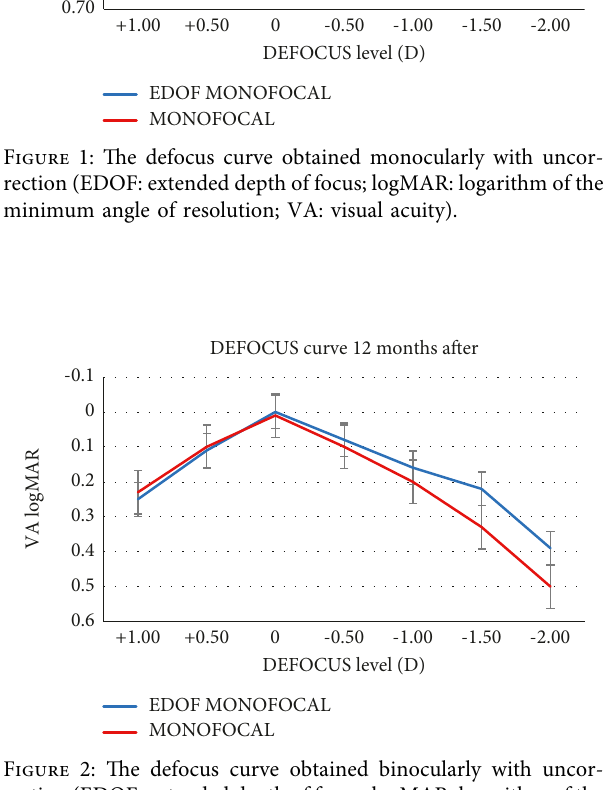
Table 4: Binocular distance-corrected defocus results. Defocus